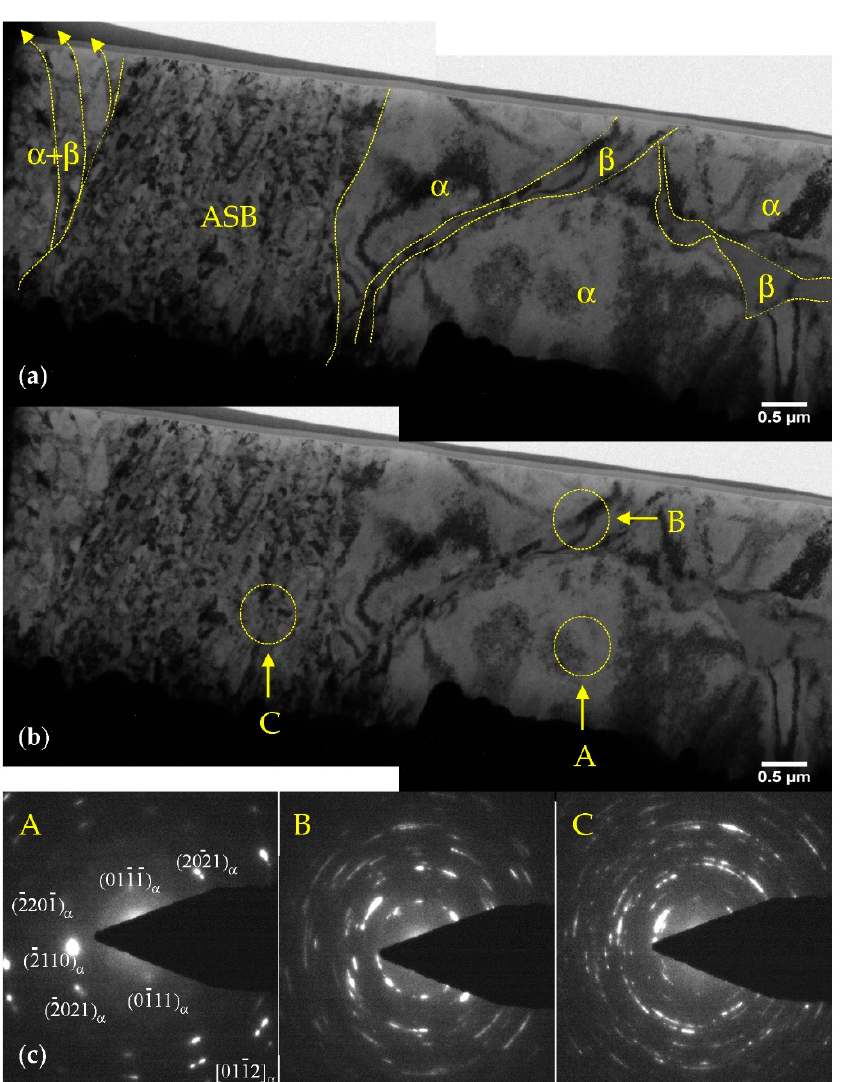
Figure 5. TEM results of the lift-off sample studied by TKD/SEM and shown in the Figure 4. Bright- field composite images of entire sample ( a , b ). The image of the top panel ( a ) shows different structures captured in the lift-off sample: ASB region, the α -globules, the β -layers and the fragmented α + β mixture. Dashed lines are used to indicate the boundaries of different structures. The central panel ( b ) shows the same image as in ( a ) but with structure boundaries not marked for ease of structure observation. The circled regions A, B and C indicate the location and approximate diameter of selected aperture where corresponding SAED patterns where taken. The bottom panel ( c ) shows the corresponding SAED patterns of the regions marked in ( b ).